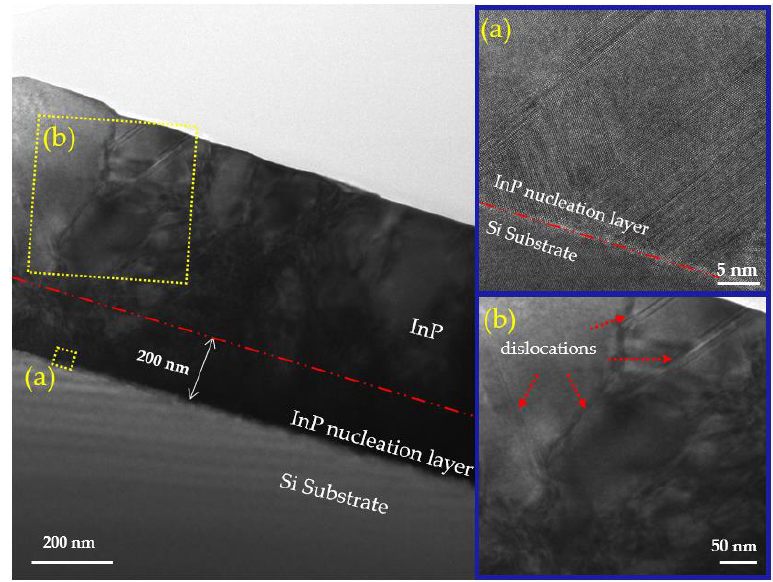
Figure 4. Cross-sectional TEM images of the InP nucleation layers grown on Si(001). Figure 4. ( a , b ) Cross-sectional TEM images of the InP nucleation layers grown on HR-XRD scan curves of different thicknesses of the InP nucleation layer on Si(001) are shown in Figure 5. It is observed that with the InP nucleation layer thickness increased from 10 nm to 200 nm, the peak intensity increased, and the FWHM values decreased, which indicates the crystal quality became better. Furthermore, according to the HR-XRD measurements, the extracted peak intensity and full width at half maximum (FWHM) of four samples are listed in Table 1, and the following formula can be used to describe the relationship between the FWHM and the thread dislocation density (TDD) [30].